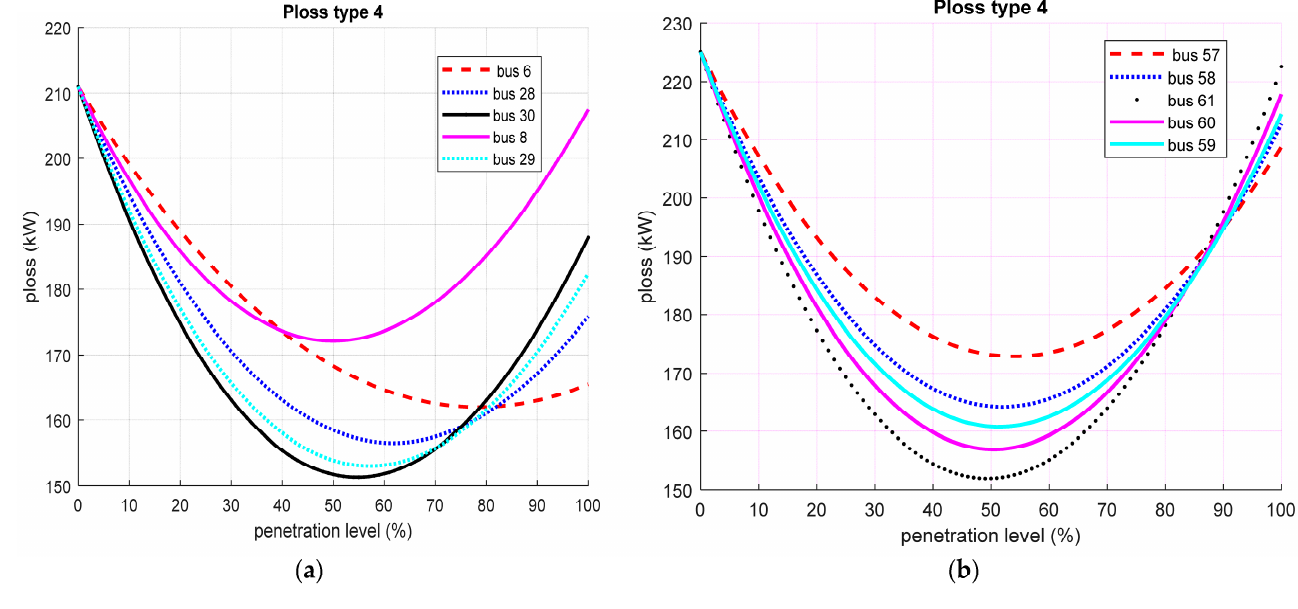
Figure 22. Real power loss when Type 4 DG was interconnected to selected nodes of the IEEE ( a ) 33-bus ( b ) 69 bus RDNs.